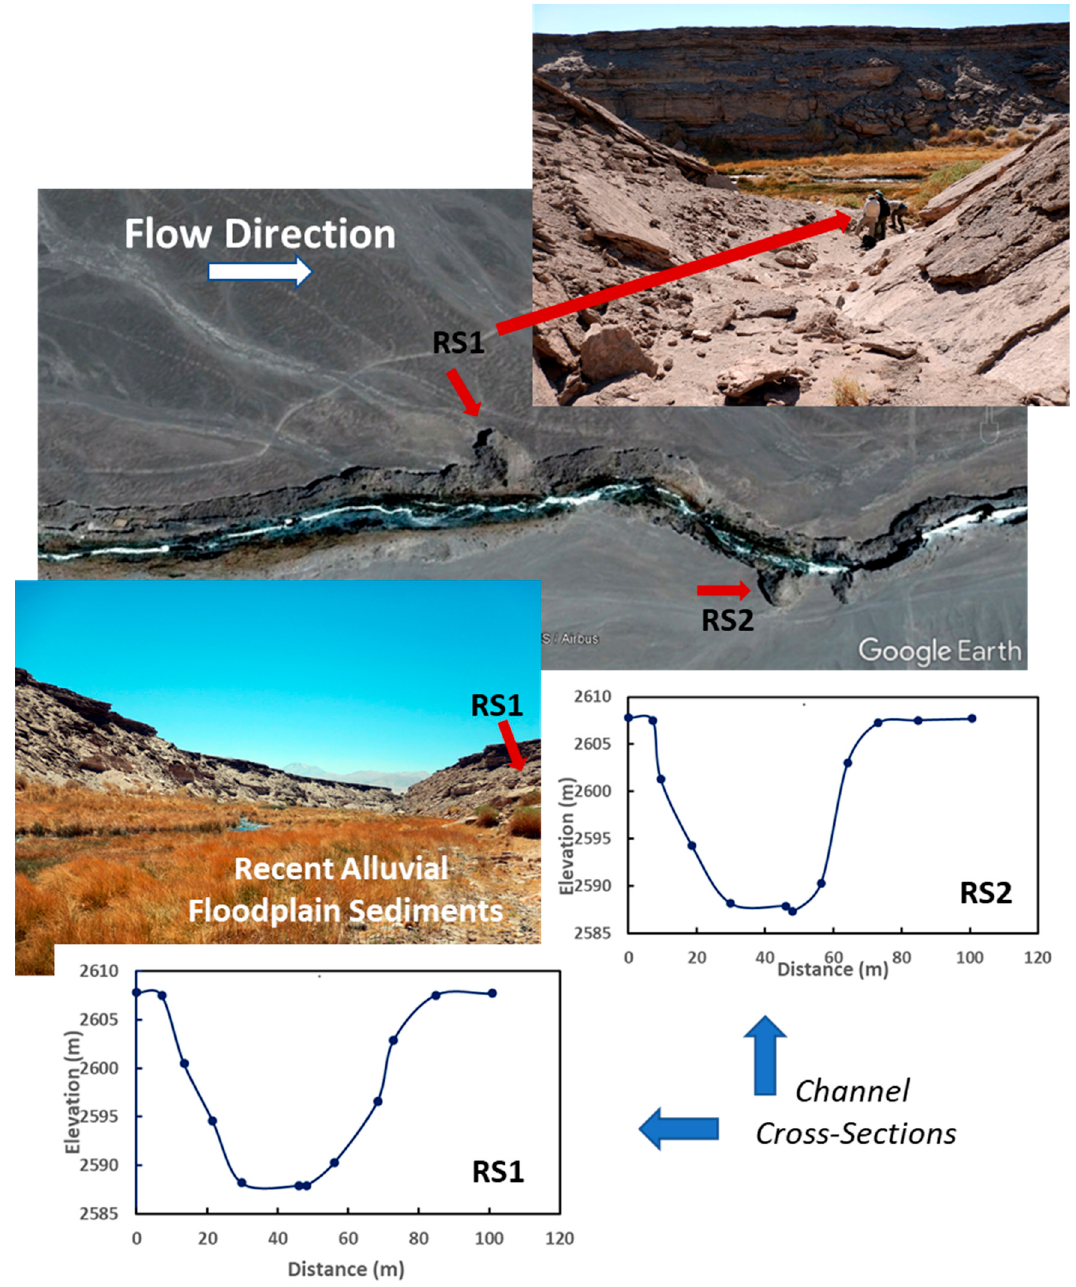
Figure 5. Geomorphic characteristics of reach PD. Channel is deeply incised into bedrock, but width and depth of the incised trench are relatively uniform.